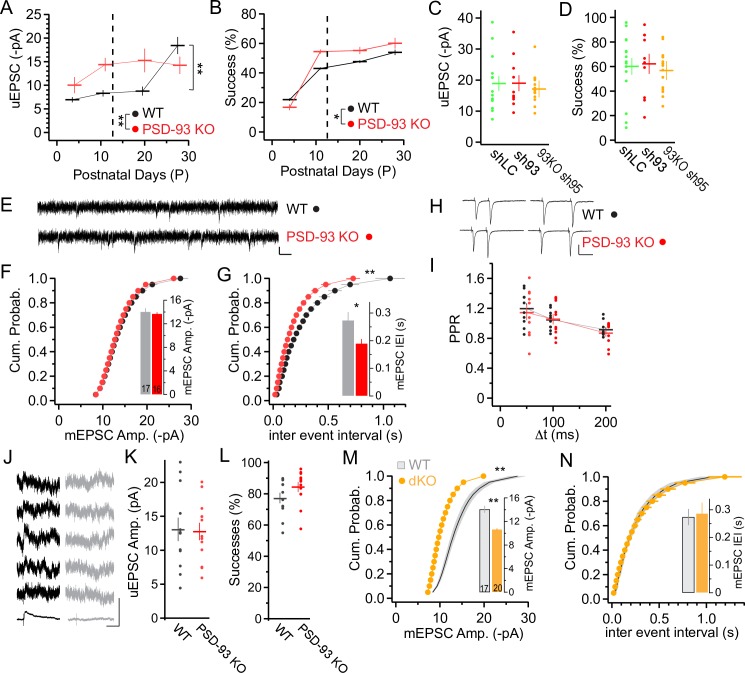
Accelerated maturation of silent synapses in PSD-93 KO mice: developmental time course of synaptic potency.(A, B) uEPSC (A) and success rate (B) of EPSCs evoked with minimal stimulation (recordings from Fig 1) in V1 slices of WT (black) and PSD-93 KO mice (red). Vertical dashed line illustrates time point of eye opening. Two-factor ANOVA for difference between genotypes and one-factor ANOVA with Tukey to test for differences between individual groups; *p < 0.05, **p < 0.01. Underlying data for this figure can be found in S1 Data. (C, D) Potency (C) and success rate (D) of EPSCs evoked with minimal stimulation from P28 WT mice, expressing shLC (green), sh93 (red), or PSD-93 KO with sh95 (orange) (recordings from Fig 2). Underlying data for this figure can be found in S1 Data. (E-G) mEPSC recordings with sample traces (E) of WT (top) or PSD-93 KO (bottom) and cumulative probability graph of mEPSC amplitude (F) and IEI (G) for WT (black) and PSD-93 KO (red) mice at P23 (P20–P26). Average mEPSC amplitude (F) and IEI (G) is illustrated in the inset. Number of layer 2/3 pyramidal neurons indicated in the foot of bar. KS test for equal distribution or t test for difference of means, *p < 0.05, **p < 0.01. Scale bar: 10 pA, 50 ms. Underlying data for this figure can be found in S1 Data. (H, I) PPR with different interstimulation intervals (Δt, 50 ms, 100 ms, 200 ms), with sample traces (H) for 50 ms and 100 ms for WT (H, top) and PSD-93 KO (H, bottom) at P24. Summary graph (I) with values for single neurons (dots) and average (horizontal line) for WT (black) and PSD-93 KO (red) mice at P25. Scale bar: 50 pA, 50 ms. Underlying data for this figure can be found in S1 Data. (J-L) Potency (K) and success rate (L) of NMDA receptor EPSCs (Vh = +40 mV) evoked with minimal stimulation from P24 WT or PSD-93 KO mice. To measure the potency, traces for successes for each cell were pooled and averaged, and the peak amplitude of the averaged trace measured and subtracted from the amplitude at the same time point of the averaged failure traces (J). Scale bar: 50 pA, 200 ms. Underlying data for this figure can be found in S1 Data. (M, N) mEPSC recordings plotted as cumulative probability graphs of mEPSC amplitude (M) and IEI (N) for WT (gray) or PSD-93/95 dKO (orange) mice at P23 (P20–P26). Average mEPSC amplitude (M) and IEI (N) are illustrated in the inset. Number of layer 2/3 pyramidal neurons indicated in the foot of bar. Data for WT are the same as in panels F and G. KS test for equal distribution or t test for difference of means, **p < 0.01. Underlying data for this figure can be found in S1 Data. dKO, double KO; EPSC, excitatory postsynaptic current; IEI, inter-event interval; KO, knock-out; KS, Kolmogorov-Smirnov; m, miniature; NMDA, N-methyl-D-aspartate; P, postnatal day; PPR, paired pulse ratio; PSD, postsynaptic density; shLC, short hairpin RNA against luciferase; sh93, short hairpin RNA against PSD-93; sh95, short hairpin RNA against PSD-95; uEPSC, unitary EPSC; Vh, holding potential; V1, primary visual cortex; WT, wild-type.